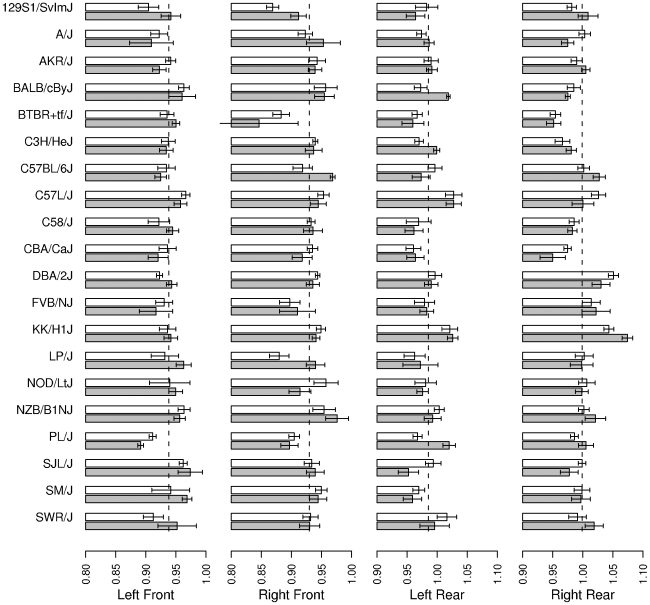
Mean 2D∶4D (±SEM) on each limb by strain and sex.Males are represented by shaded bars, females by open bars. Dotted lines mark the global mean for each paw.